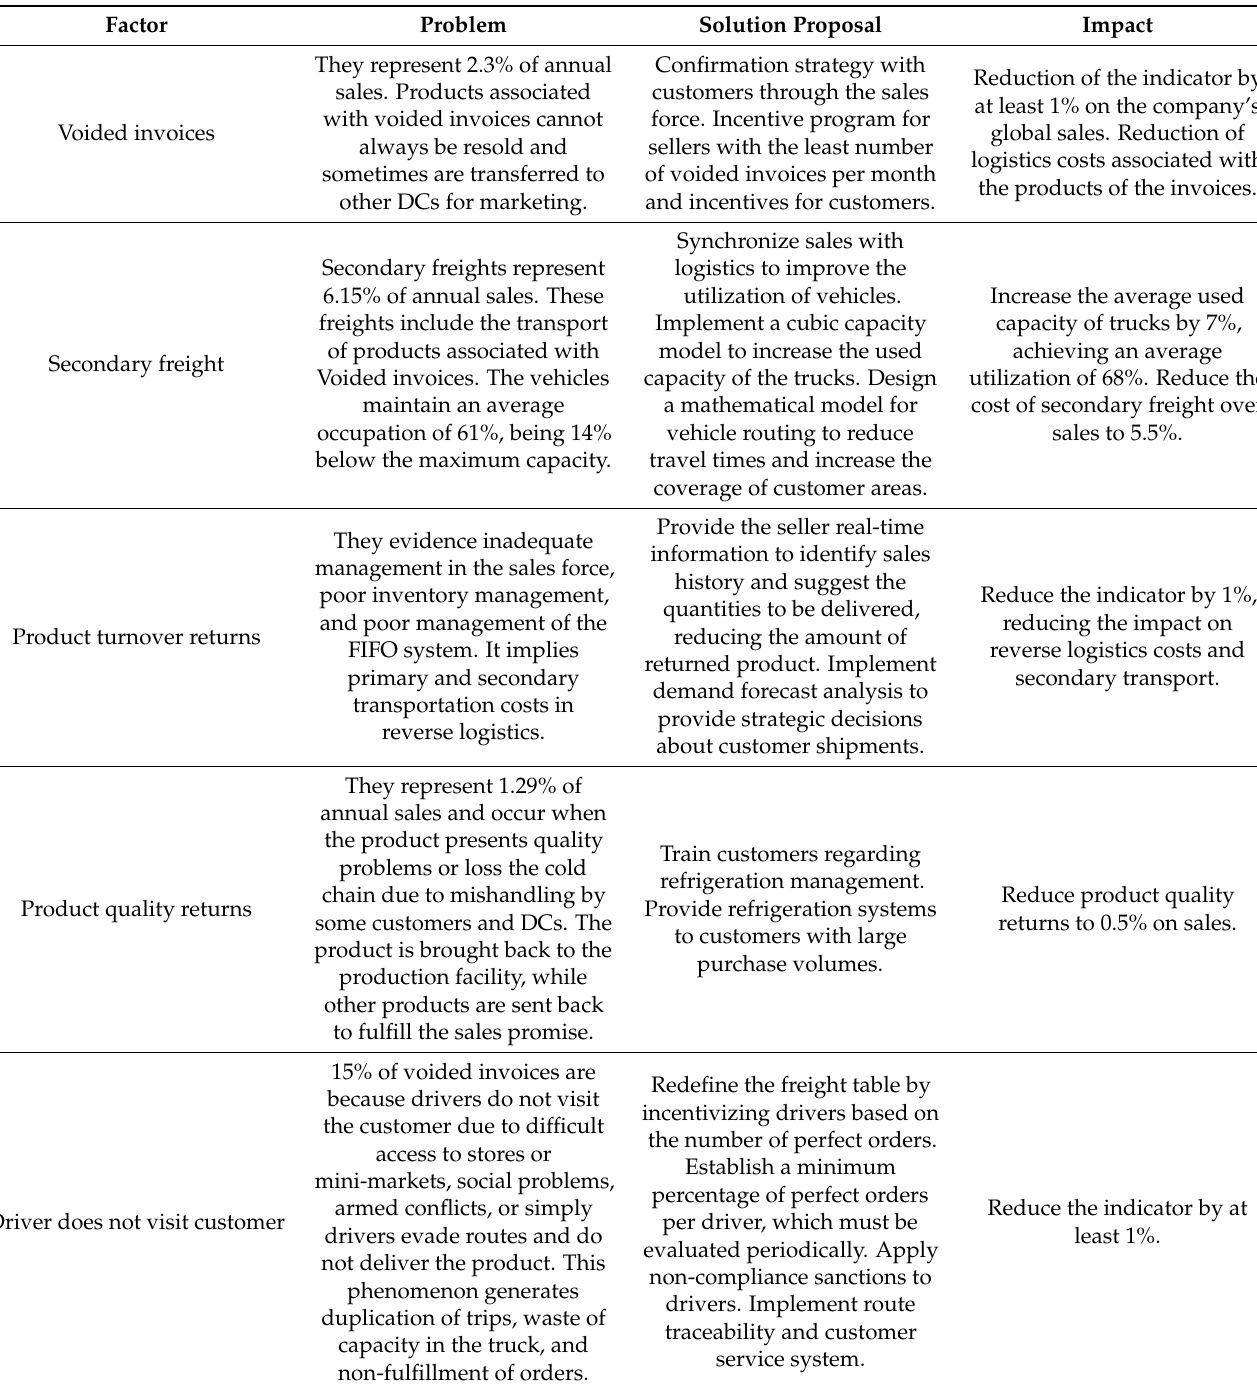
Table 8. Improvement opportunities for CTL